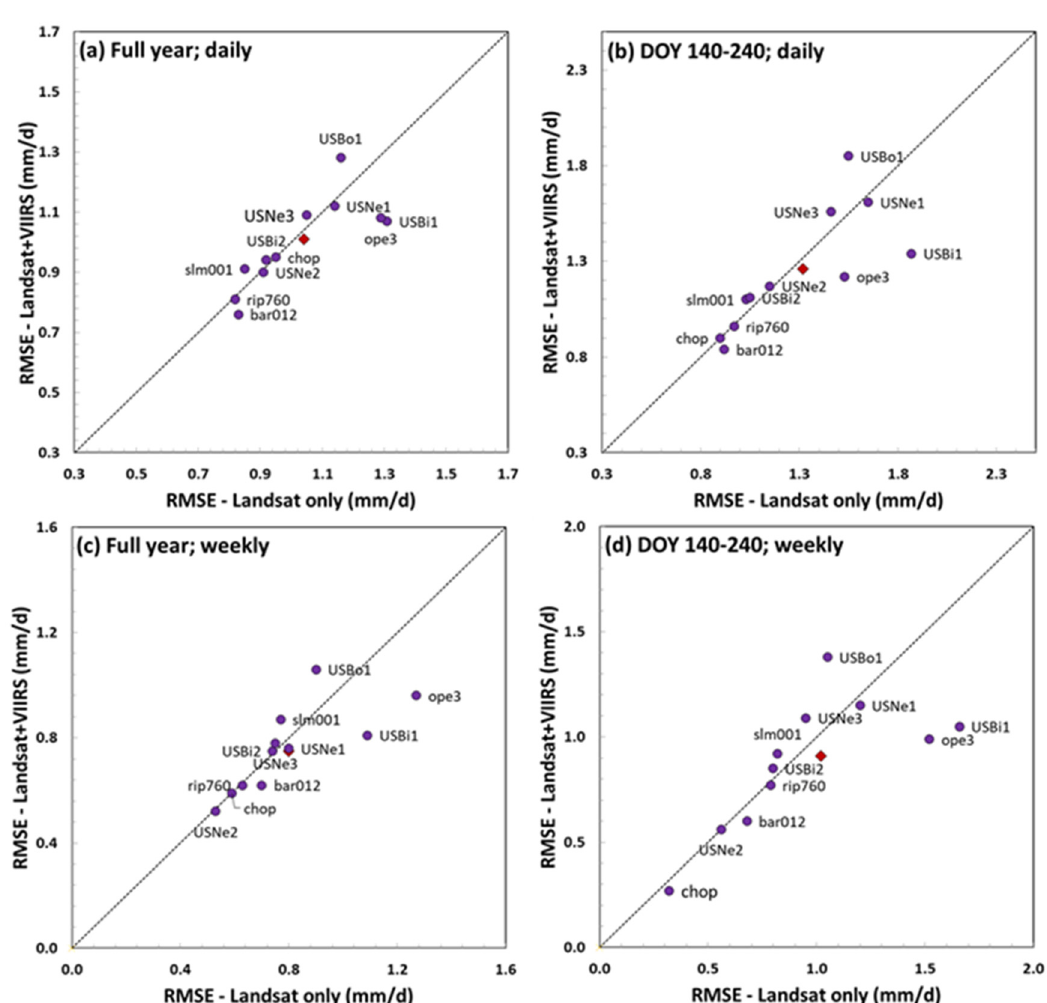
Figure 8. Comparison of RMSE in ( a , b ) daily and ( c , d ) weekly ET developed with and without VIIRS over ( a , c ) the full year of 2018 and ( b , d ) peak growing season (DOY 140–240).